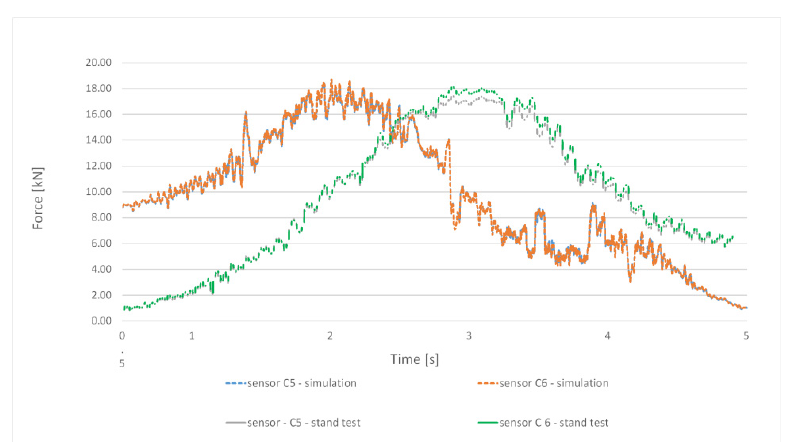
Figure 8. Force values in the diagonal suspensions at travel speed 3 m/s. Forces in the vertical suspensions at travel speed 5 m/s are presented in Figure 9.